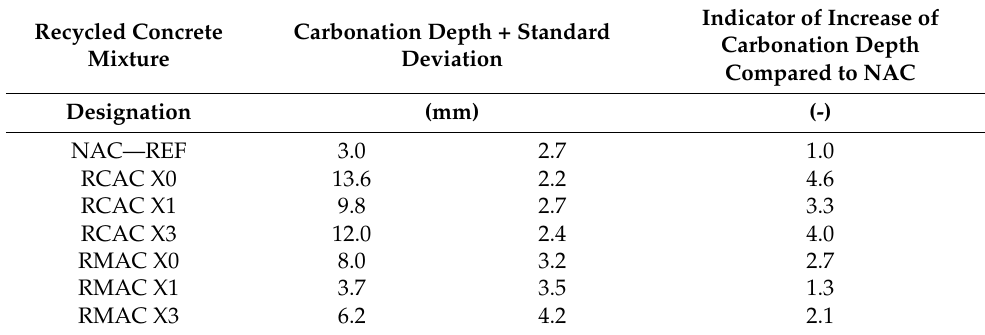
Table 8. Carbonation depth and indicator of increase of carbonation depth compared to NAC after 28 days in laboratory incubator with air circulation with CO 2 atmosphere.